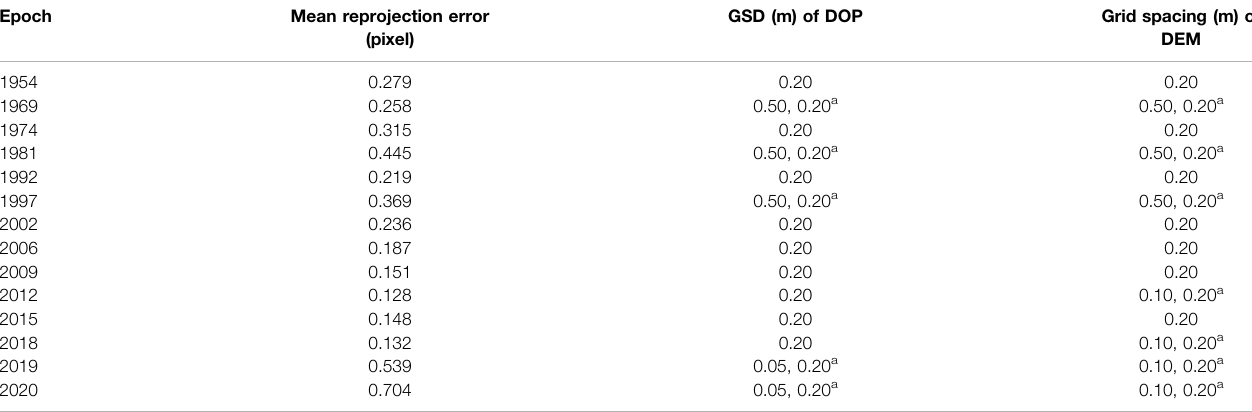
TABLE 3 | Technical parameters of bundle block adjustment and DOPs and DEMs generated. Epoch Mean reprojection error